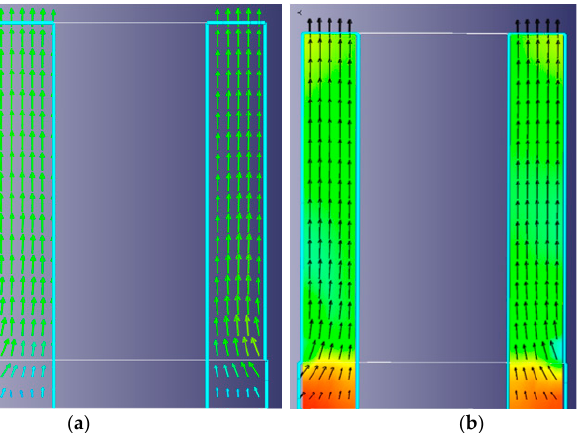
Figure 2. Distribution of air flow velocity ( a ) and pressure ( b ) in a vertical channel with a closed end at air velocity V P = 5 m/s.